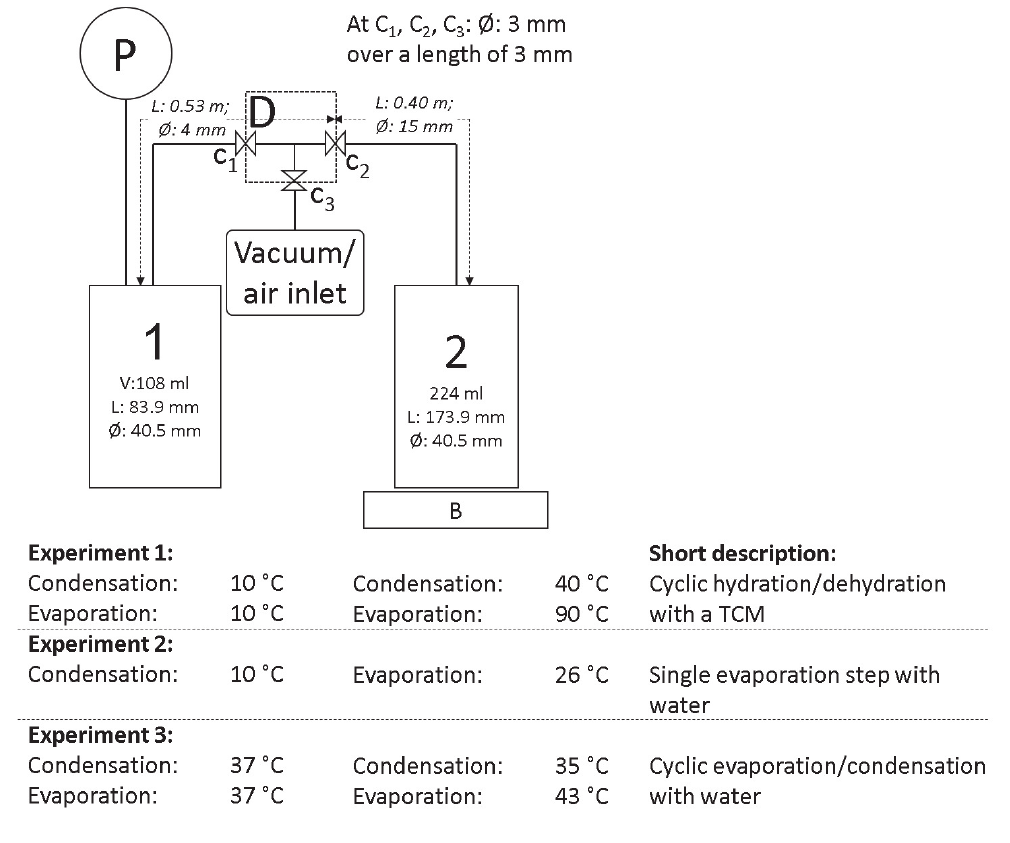
Figure 1. Schematic overview of the pT -mass setup. Both vessels are temperature controlled, the tubing between the vessels is heated to avoid condensation. The symbols represent: P: pressure sensor, D: filling area, C 1,2,3 valves, B: balance, 1 and 2: vessel 1 and 2. Vessel 1 always water, vessel 2